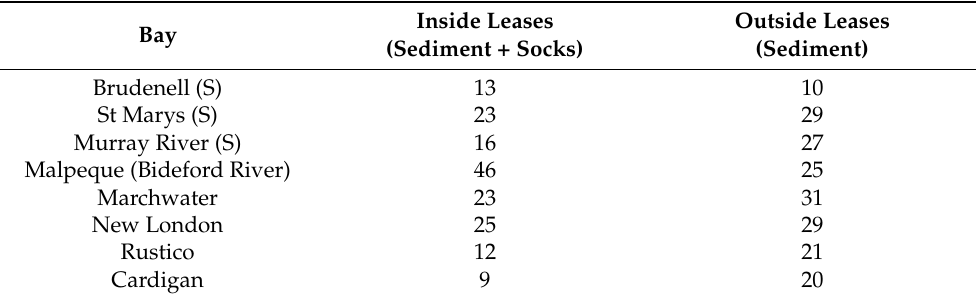
Table 7. Number of taxa observed per 0.039 m 2 of bottom area inside and outside mussel leases in 8 bays on PEI. (S) indicates bays with Styela clava